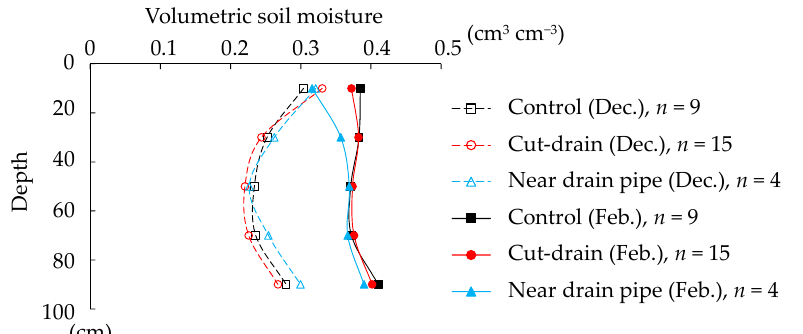
Figure 5. Changes in soil moisture before and after leaching. The figure shows soil moisture for each layer of 20 cm before and after leaching. The n represents the number of sampling plots. The data were the average values in the control field, cut-drain part, and near the drain pipe,